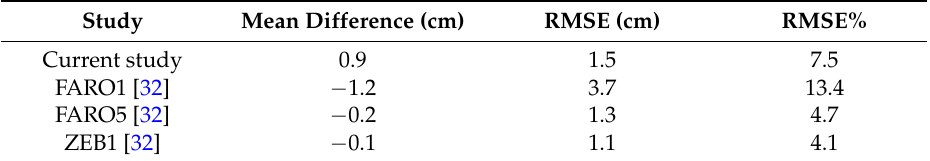
Table 5. Result for estimated DBH in the current study compared to Bauwens et al.